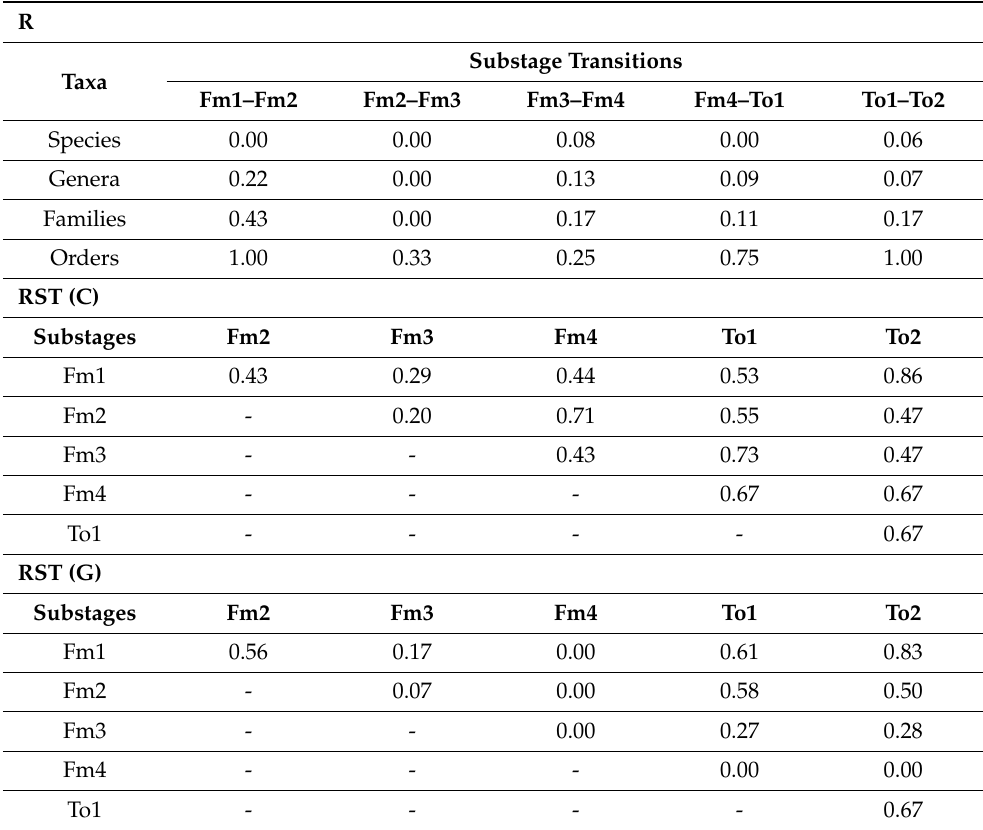
Table 2. R and RST indices for the studied bryozoan assemblages.